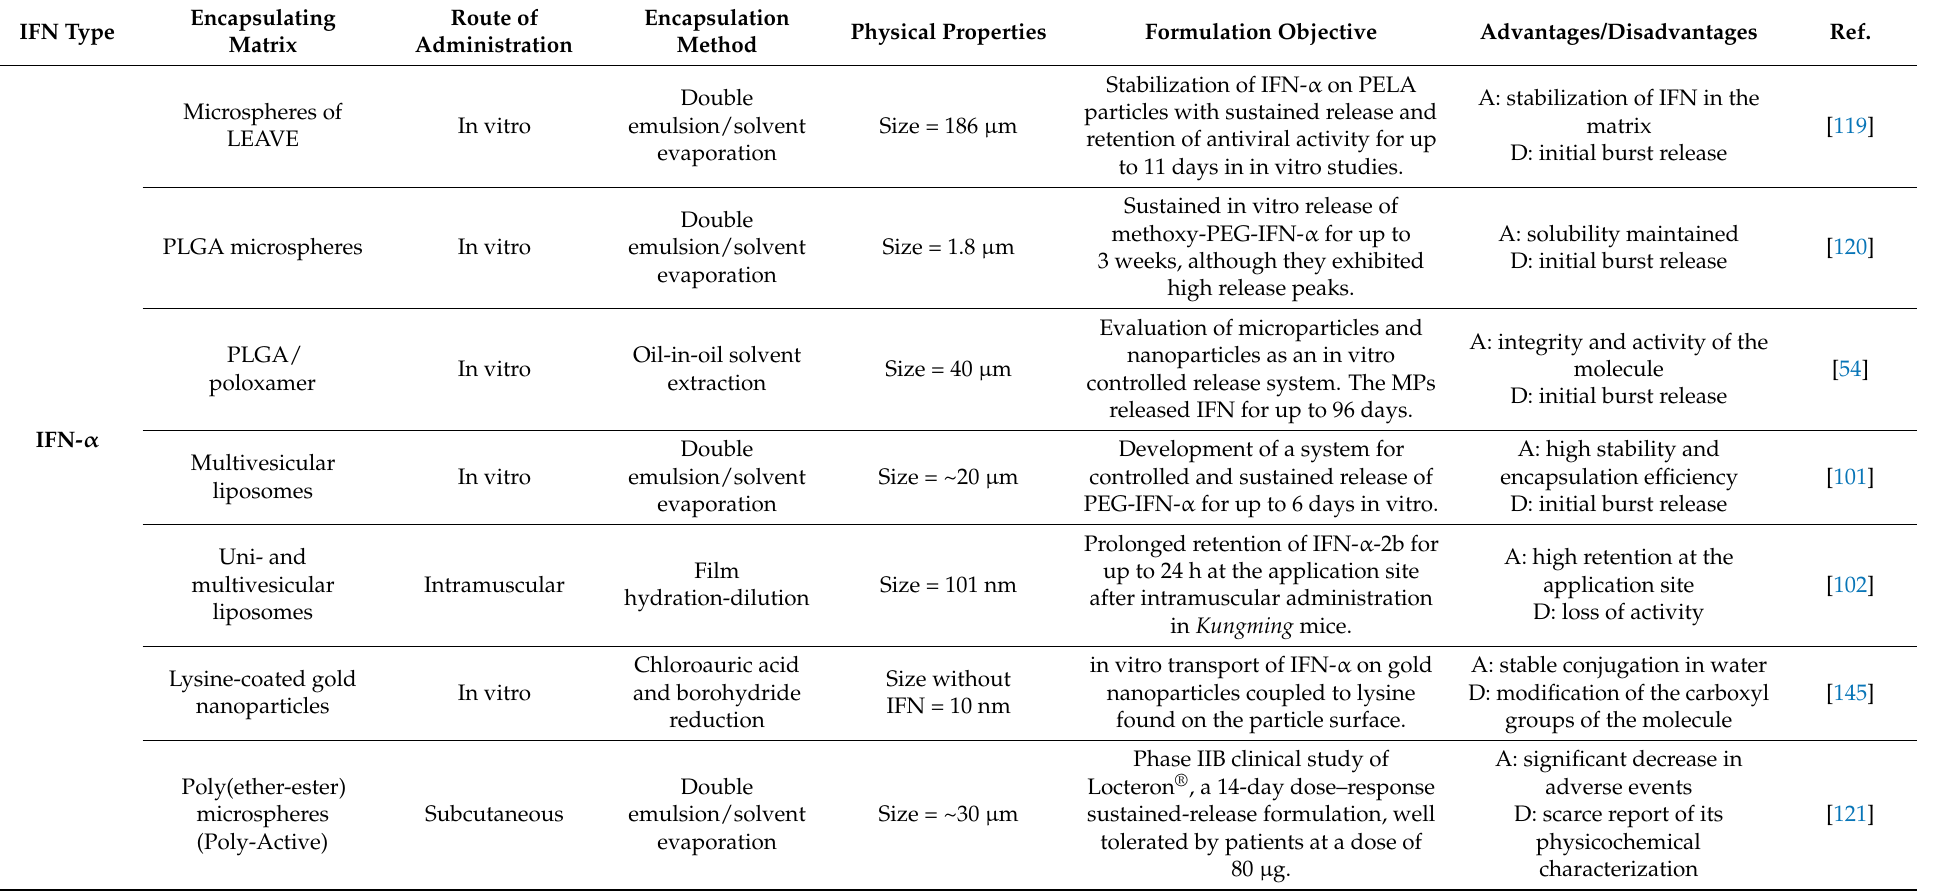
Table 1. Comparative table summarizing all forms of IFN- α , IFN- β , and IFN- γ delivery systems described in the scientific literature from 1996 to March